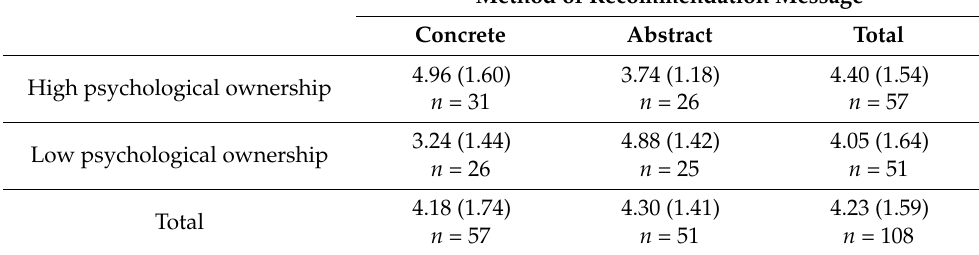
Table 2. Descriptive statics.